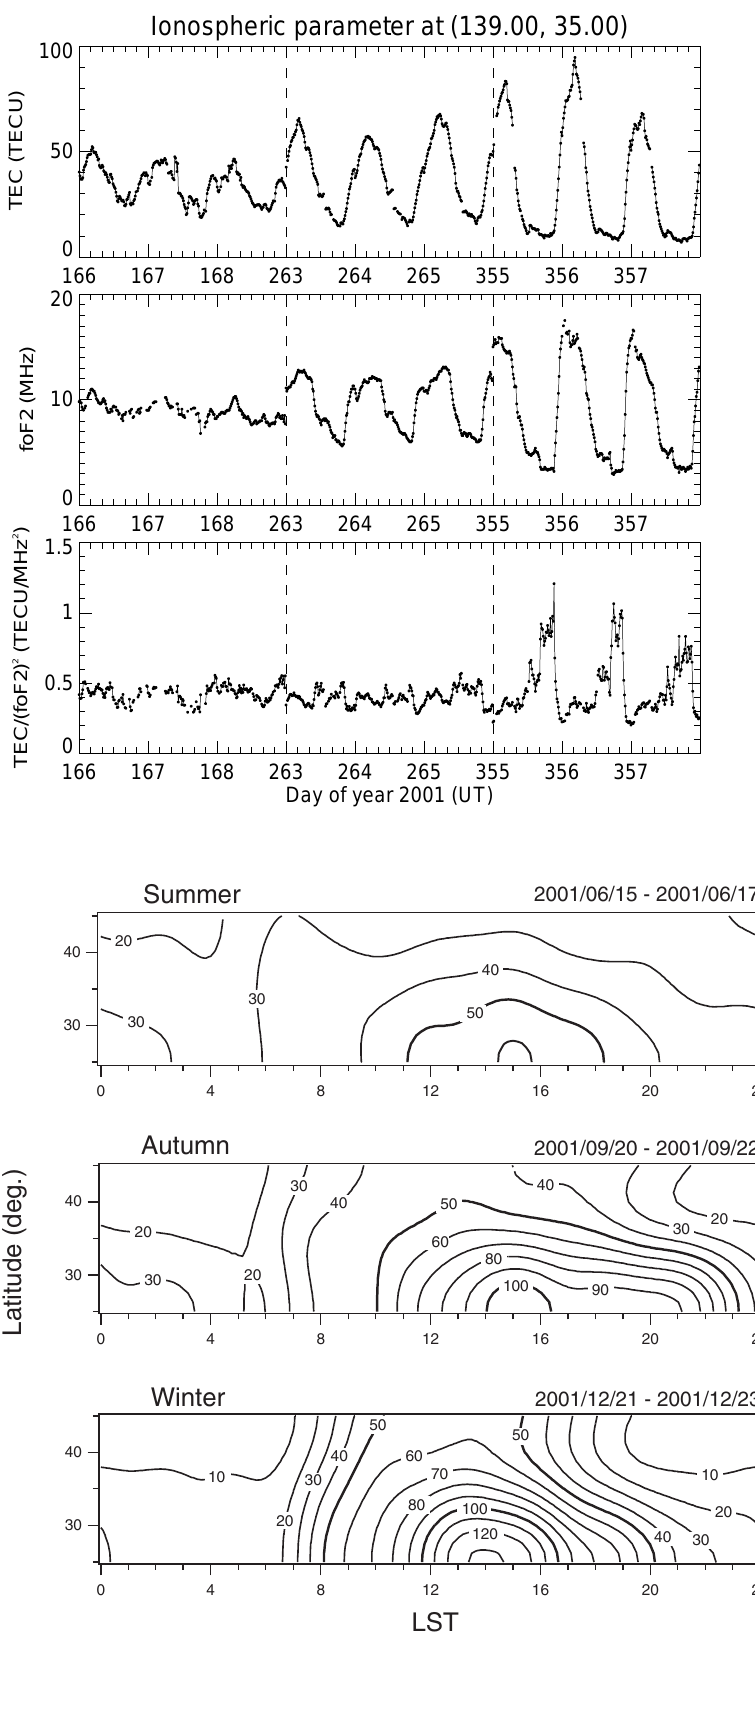
Fig. 7. Ionospheric distribution over Japan in the summer, the autumn, and the winter of 2001. Contours are la- beled in units of TECU and the spacing is 10